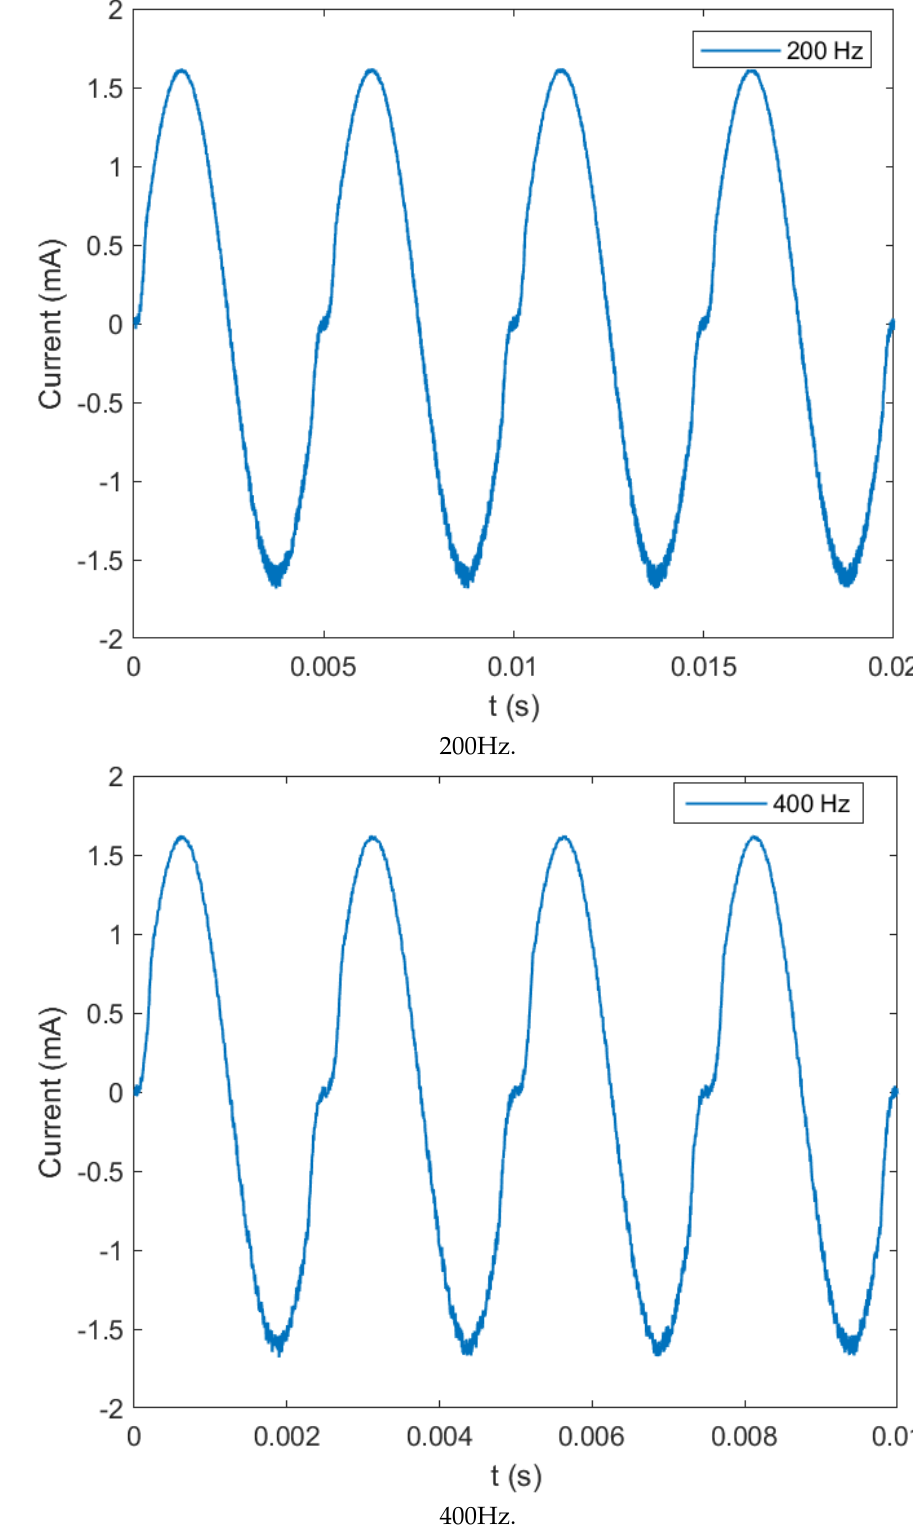
Figure 12. Temporal graphs of the measured response (current signals) of the realized memristor at 3 different frequencies corresponding to the simulated frequencies for driving sine voltage of ( a ) 100 Hz, ( b ) 200 Hz, and ( c ) 400